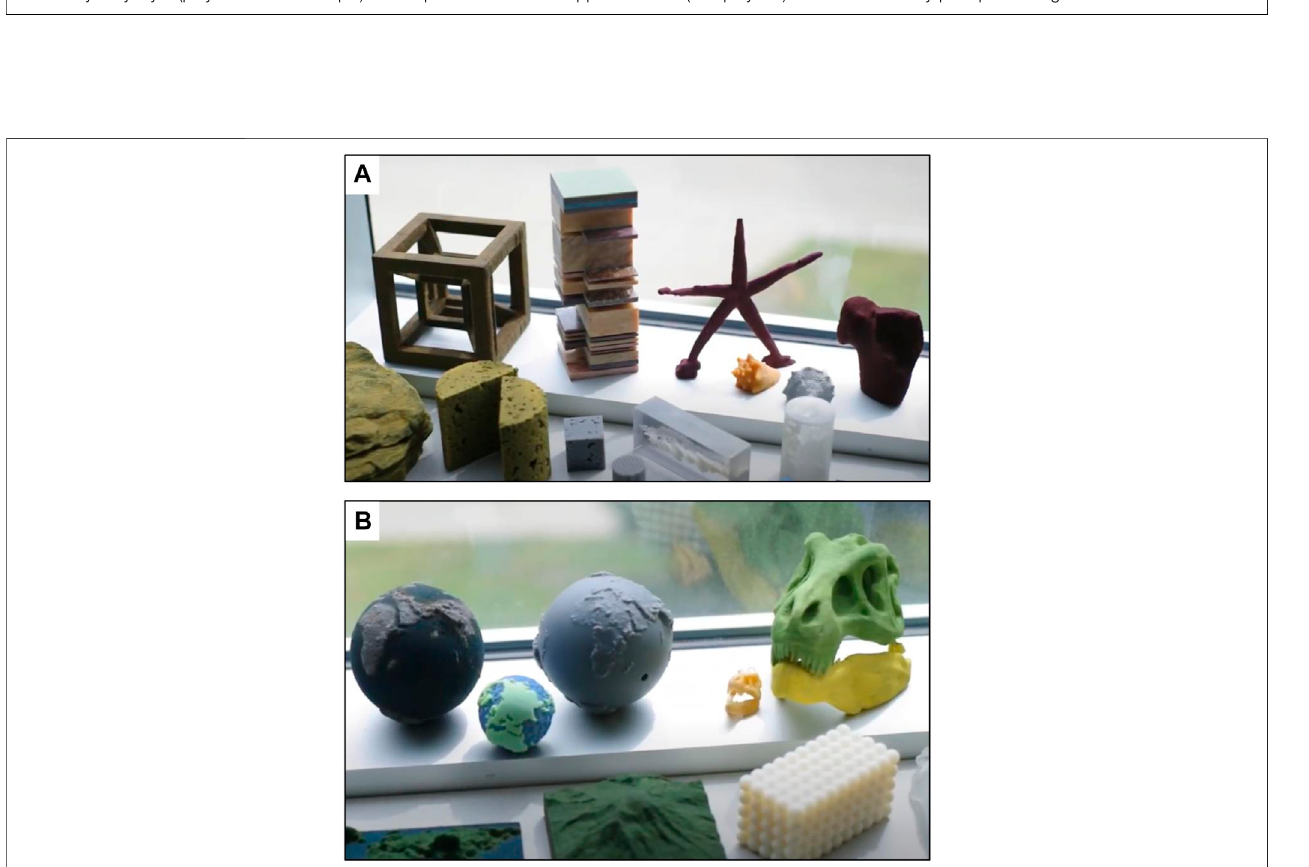
FIGURE 11 | Examples of 3D-printed models used in course exercises. (A) Fossil and rock specimens. (B) Geomorphology and porous models.